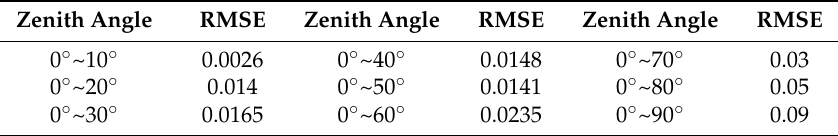
Figure 7. Cosine performance of the upward optical sensor. Table 1. Relationship between zenith angle range and RMSE.